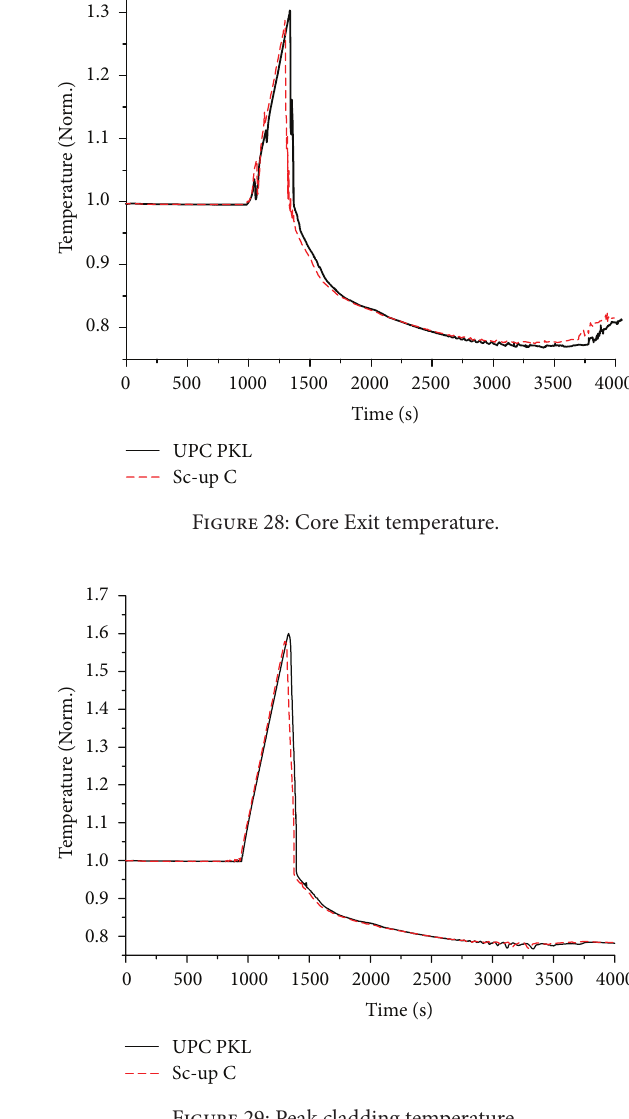
Figure 29: Peak cladding temperature.